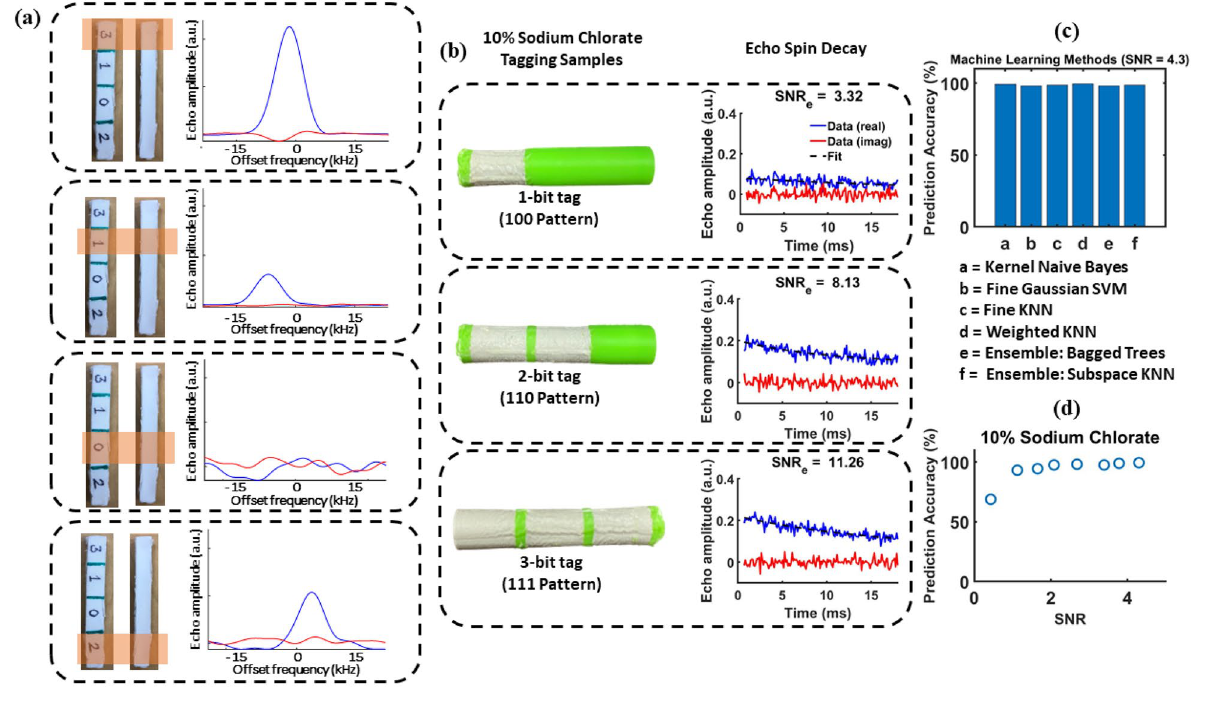
Figure 4. ( a ) Signatures from specific parts of the sample are read out using a spatially-selective “hollow coil” detector; each signature has a different value of the peak amplitude A . The number on the label represents the relative amount of NaClO 3 used for tagging. ( b ) Cylindrical samples containing three tagging locations, each using 10% NaClO 3 filament. The figure shows three of the possible binary patterns and their field-dependent relaxation decays. ( c ) Signature prediction accuracy of different machine learning (ML)-based classification methods (listed on the figure). ( d ) Measured improvement in prediction accuracy with increase in SNR for 3-bit patterns (10% NaClO 3 ) [Microsoft